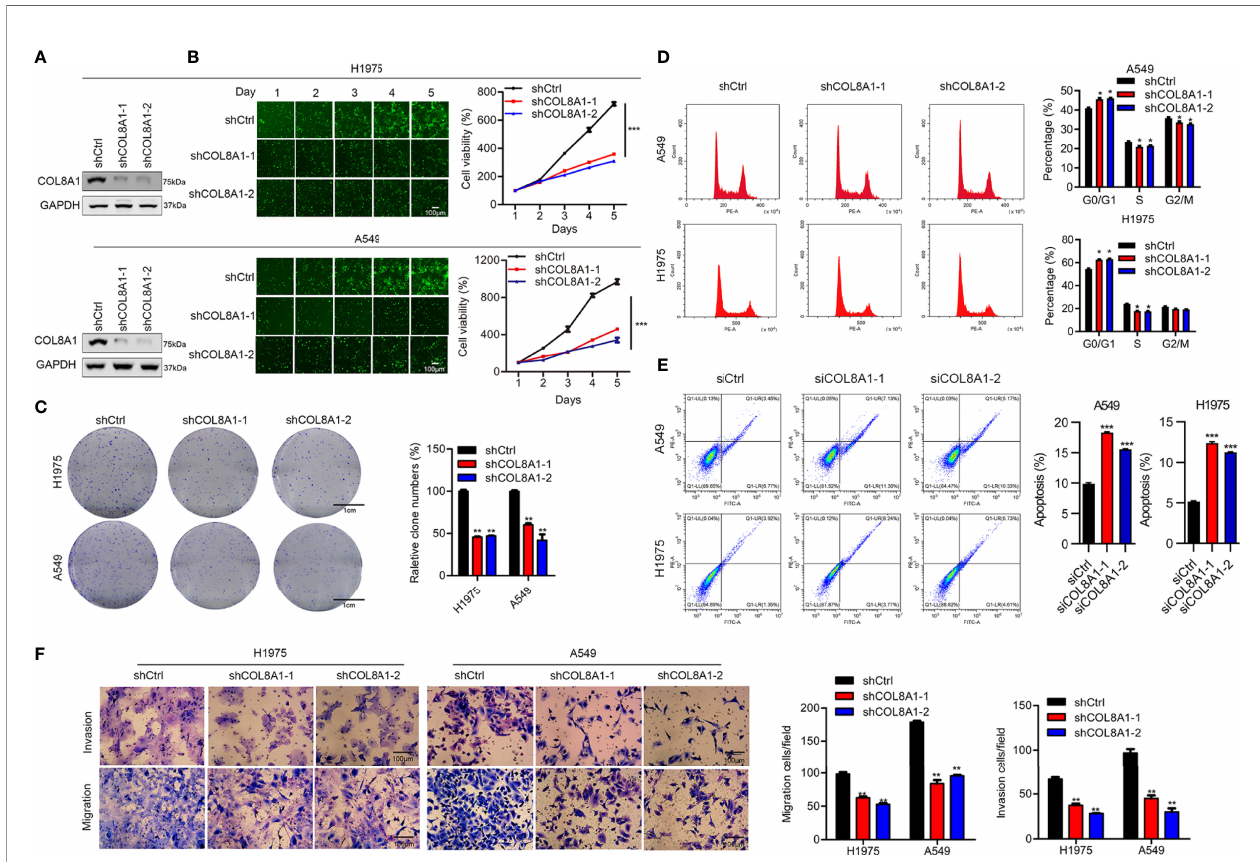
FIGURE 2 | Knockdown of COL8A1 suppresses NSCLC cell line progression. (A) Knockdown ef fi ciency of lentivirus-mediated COL8A1-knockdown in A549 and H1975 cells determined by western blot assay. (B) Cell proliferation curves generated using cell viability assays. (C) Representative image of the results of colony formation assays, showing crystal violet staining. (D) Cell cycle analysis examined by fl ow cytometry. (E) Cell apoptosis assays of A549 and H1975 NSCLC. (F) Cell migration and invasion capacity of COL8A1-silenced NSCLC cells determined by transwell assays of A549 and H1975 cells. *p < 0.05. **p < 0.01. ***p <